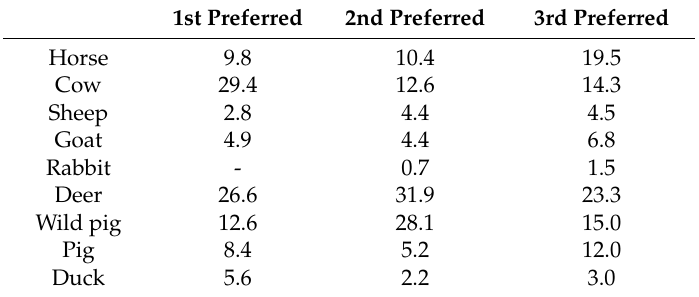
Table 3. Preference of ‘cecina’ from different species (percentage; n = 145 consumers). 1st Preferred 2nd